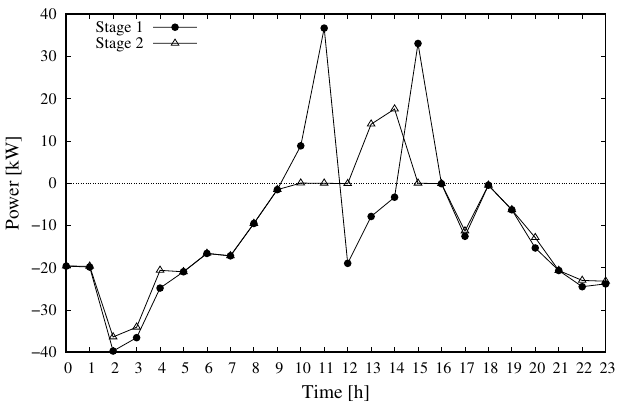
Figure 10. Case B. Aggregate profile of the energy community, computed at the end of the first and second stages when using the Parallel approach. Positive (negative) values correspond to the energy injected to (absorbed from) the